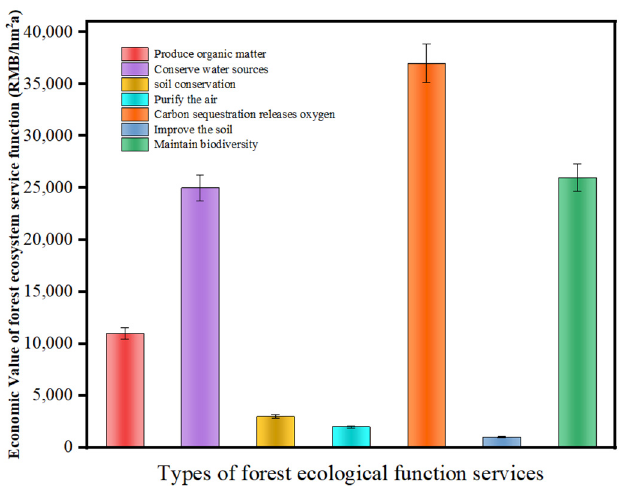
Figure 4. Ecological service function value of Liquidambar formosana plantation ecosystem .